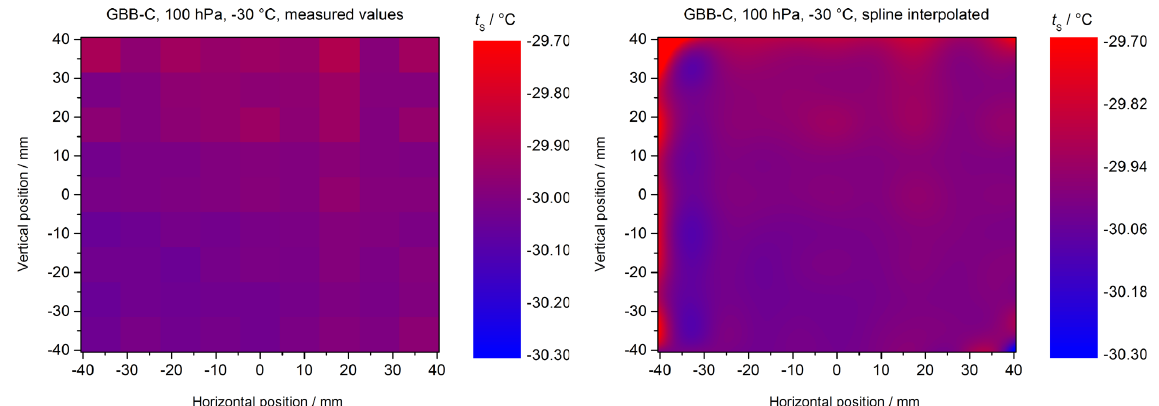
Fig. 16. The spatial distribution of the radiation temperature of the GLORIA blackbody GBB-C at a nominal temperature of − 30 ◦ C and 100 hPa. The field-of-view is 82 mm × 82 mm. The measured data is shown on the left panel, the spline interpolated data on the right. The homogeneity is 35 mK (standard deviation).